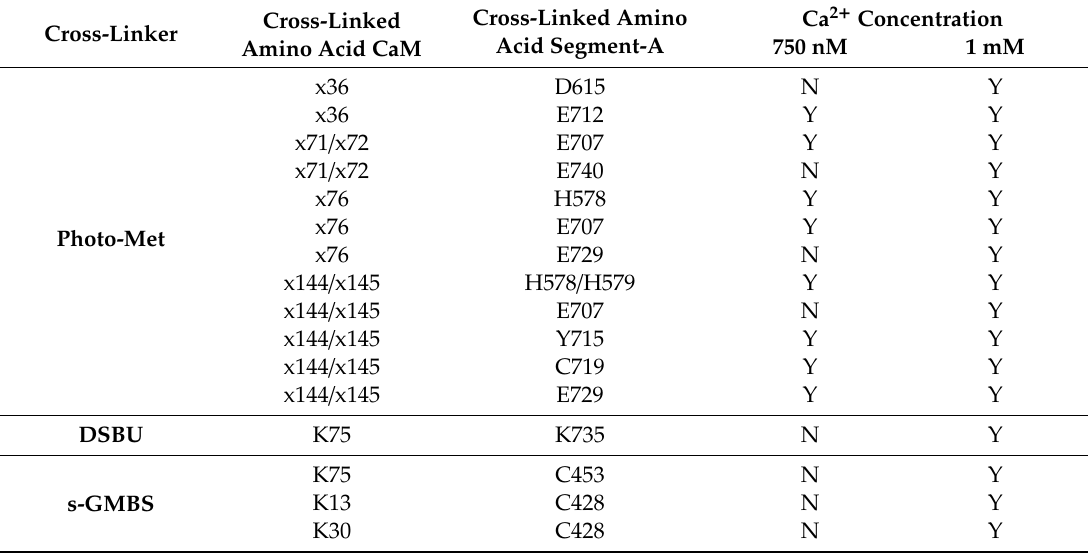
Table 1. Intermolecular cross-links identified between CaM and the bMunc13-2 segment-A at 750 nM and 1 mM Ca 2 + . x denotes photo-Met; Y, cross-link detected; N, cross-link not detected. Cross-Linker